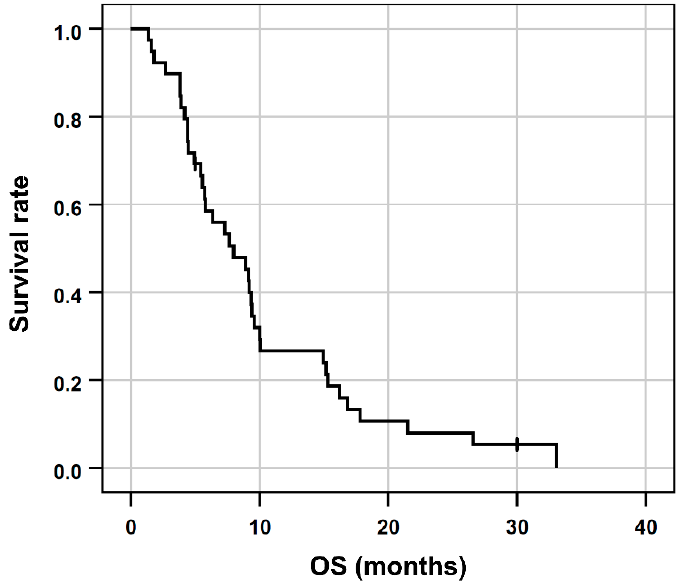
Figure 1. Kaplan-Meier plots regarding OS of the entire patient